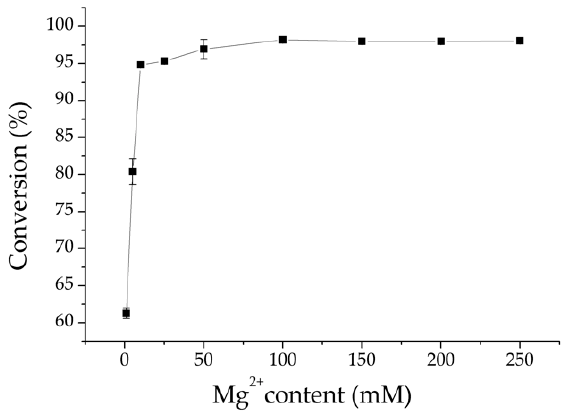
Figure 5. Optimization of Mg 2+ content in terms of conversion of mannose with polyphosphate- dependent mannose kinase, mannose (20 g/L), and (NaPO 3 ) 6 (60 g/L) at 30 °C at pH 8.5. The effect of Mg 2+ content on the conversion was mainly at concentrations below 10 mM. When the concentration was more than 10 mM, the conversion efficiency was above 95%, and the change with Mg 2+ content was not significant.